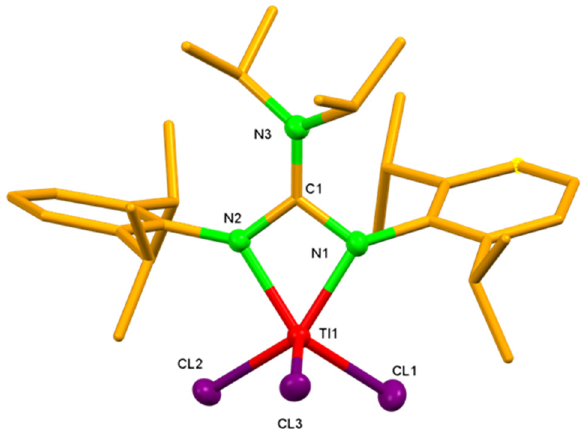
Figure 2. Molecular structure of 1 . Ellipsoids are set at 50% probability; hydrogen atoms are omitted for clarity. Selected bond lengths [Å] and angles [°]: C1-N2-1.350(3), C1-N3-1.353(3), C1-N1 1.373(3), N1-Ti1 2.008(2), N2-Ti1 2.049(2), Cl1-Ti1 2.2461(9), Cl2-Ti1 2.2565(9), Cl3-Ti1 2.2185(8); N2-C1-N3 129.1(2), N2-C1-N1 105.9(2), N3-C1-N1 124.9(2), N2-C1-Ti1 54.14(13), N3-C1-Ti1 168.93(19), N1-C1-